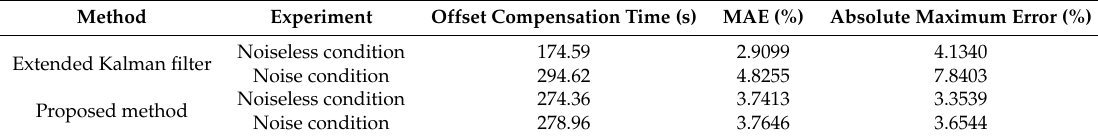
Table 3. SOC estimation results for different experimental conditions using both